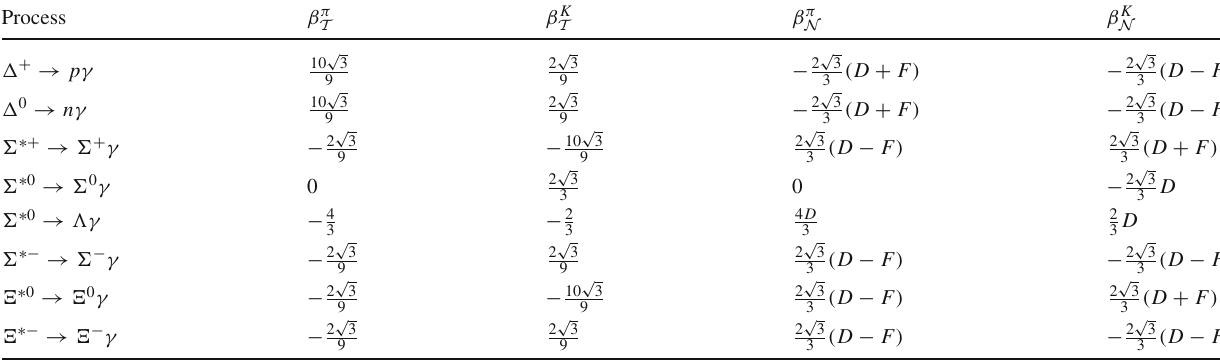
Table 7 The coefficients of the loop corrections to the decuplet to octet baryon transition magnetic moments from Figs. 2(a) and 2(b). The sub- scripts “ T ” and “ N ” denote the decuplet and octet baryon within the loop while the superscripts denote the pseudoscalar meson. What calls for special attention is that the pion loop coefficients of (cid:13) ∗ 0 → (cid:13) 0 γ